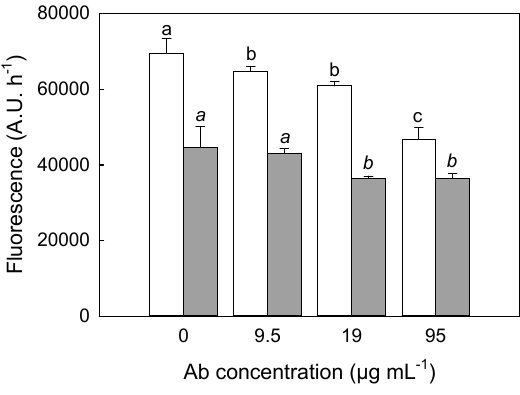
Figure 4. Inhibition of the chitinase activity of S. griseus and RGSM chitinase by anti-peptide Ab. Chitinolytic activity was measured as described in Schuttelkopf et al. [23]. 0.2 µg·µL − 1 of S. griseus chitinase (white bars) and 30 µg of RGSM (grey bars) were assayed in the presence of increasing concentrations of anti-peptide Ab. Different letters assigned to means designate a statistical difference regarding data from S. griseus (not italic letters), or from RGSM samples (italic letters).